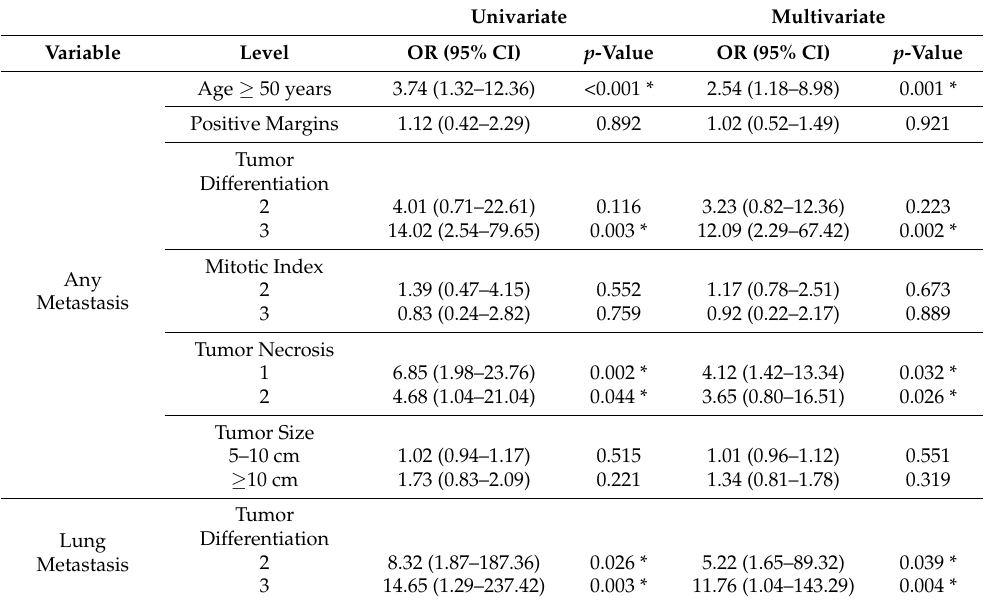
Table 2. Univariate and Multivariate Analysis of Prognostic Factors for Metastatic Disease. * indicate significant results, p -value <